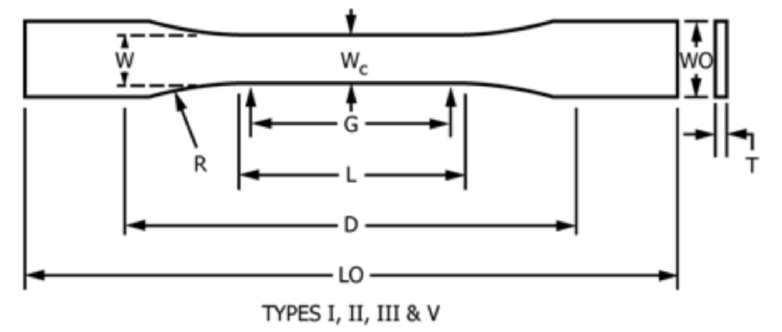
Figure 3. Dog bone specimen